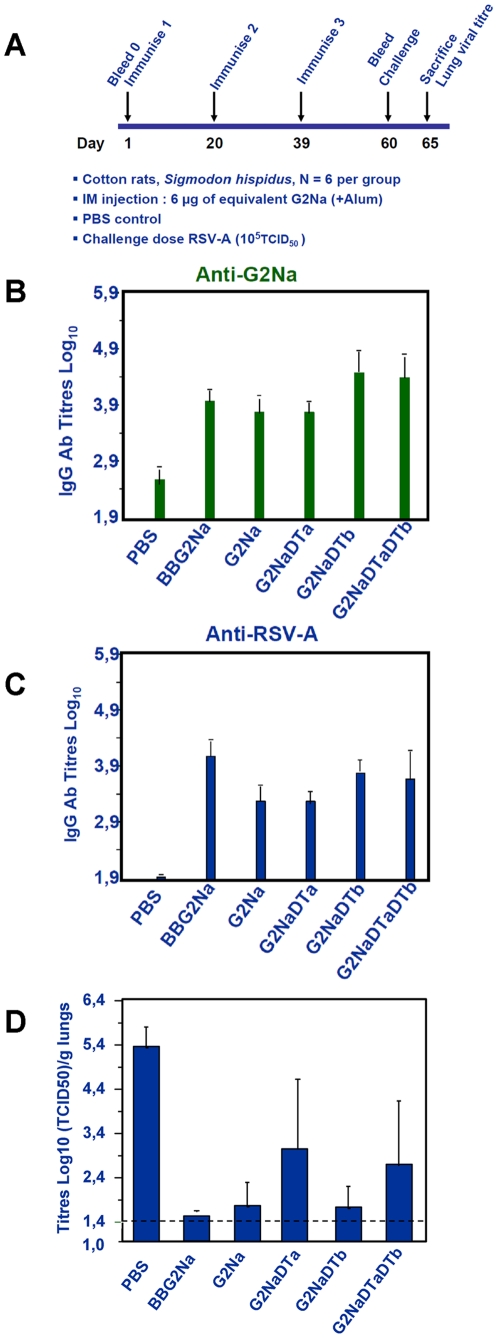
Immunogenicity and protective efficacy against RSV-A conferred by G2Na, BBG2Na, G2NaDTa, G2NaDTb and G2NaDTaDTb in cotton rats.Groups of animals were immunised thrice im with G2Na derivatives according to the outlined experimental protocol (A). After the 3rd injection, on D60, we determined by ELISA the (B) anti-G2Na IgG Ab titre, (C) anti-RSV-A (Long) IgG Ab titre. Five days after challenge with RSV-A (105 TCID50) we evaluated protective efficacy by determining the RSV-A titre in the lungs of immunised animals. Data were expressed as Log10 TCID50/g lung tissue. The dotted line represents the detection limit of RSV-A in the lungs.